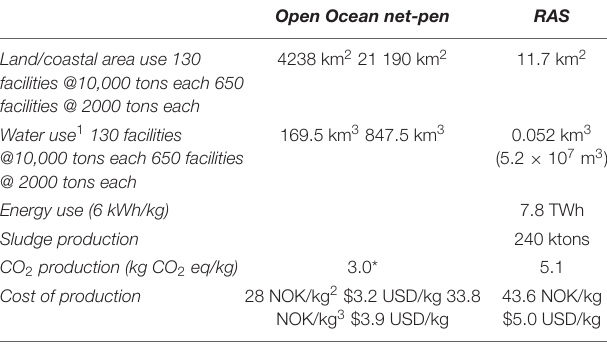
TABLE 1 | Comparison of production requirements for 1.3 M tons of Atlantic salmon ( Salmo salar ), currently produced in Norway in ocean net-pen farming with that same production in recirculating aquaculture systems